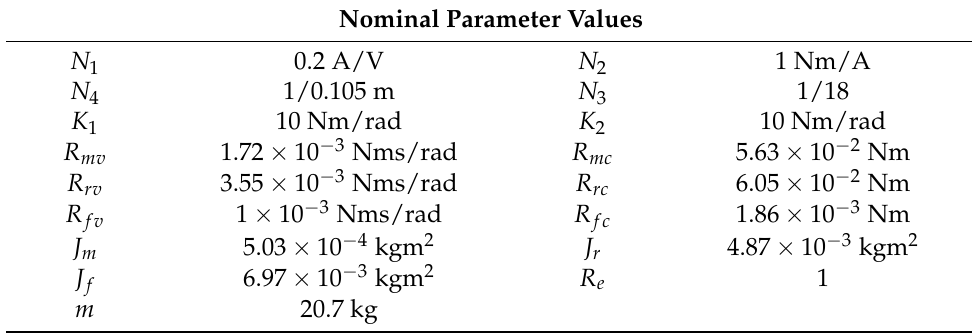
Table 3. Nominal values of electric scooter parameter.